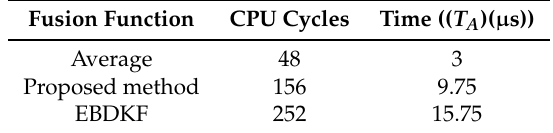
Table 4. CPU overhead of different information fusion functions for hierarchical